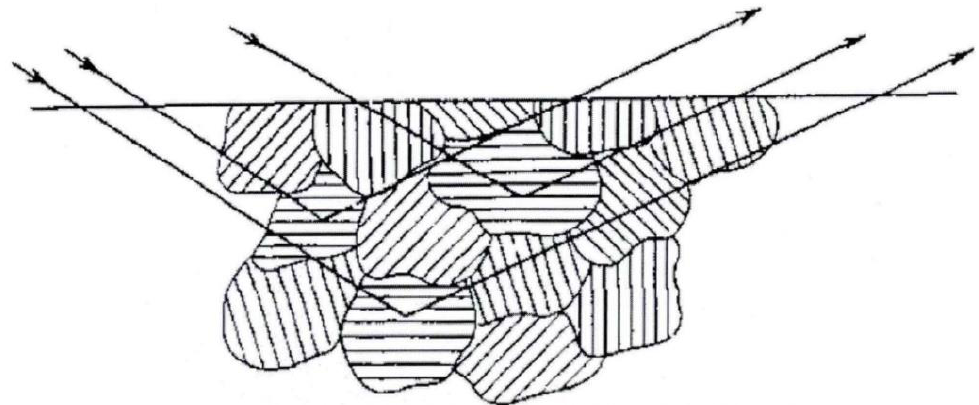
Figure 3. Part of the grain producing effective diffraction for a certain face in the polycrystalline aggregate [23].